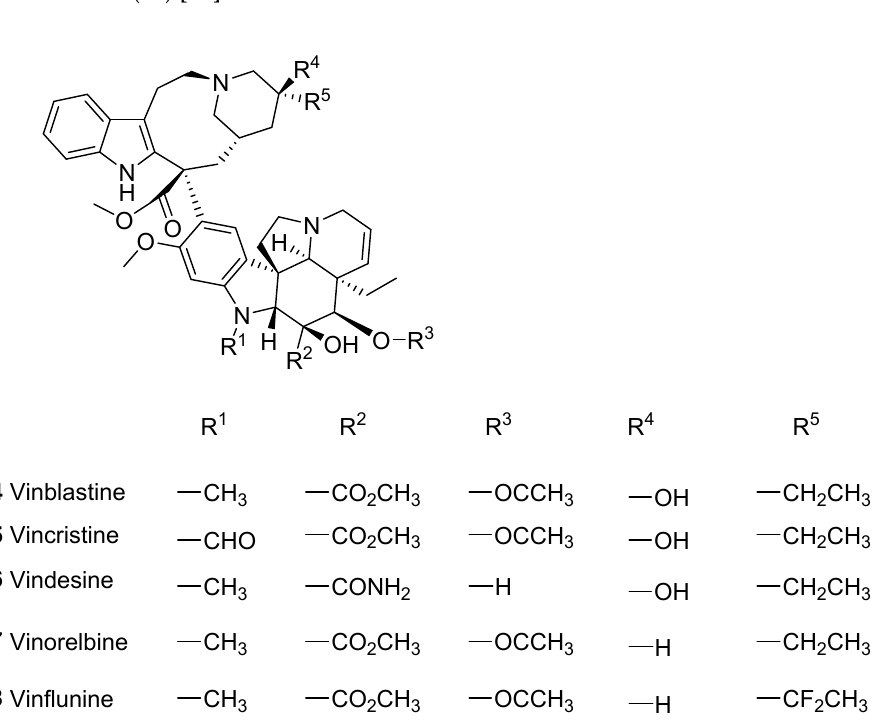
Figure 19. Vinblastine ( 54 ) and vincristine ( 55 ) are native natural products, whereas vindesine ( 56 ), vinorelbine ( 57 ) and vinflunine ( 58 ) are semisynthetic analogues [11]. Inspection of the structures of all the clinical used alkaloids reveals that they all possess the same carbon skeleton. Vincristine ( 55 ) is a formamide of dihydroindole, and vinblastine ( 54 ) is the N -methyldihydroindole. A formation of a bond from the α -methylester carbon of catharanthine (Scheme 5, 60 ) and the carbon ortho to the methoxy group of vindoline ( 59 ) created the dimeric carbon skeleton. The biosynthetic reaction is catalyzed by α -3’.4’- anhydrovinbalse synthase (Scheme 5) [22]. The dimerization is a complex reaction, which is described in details